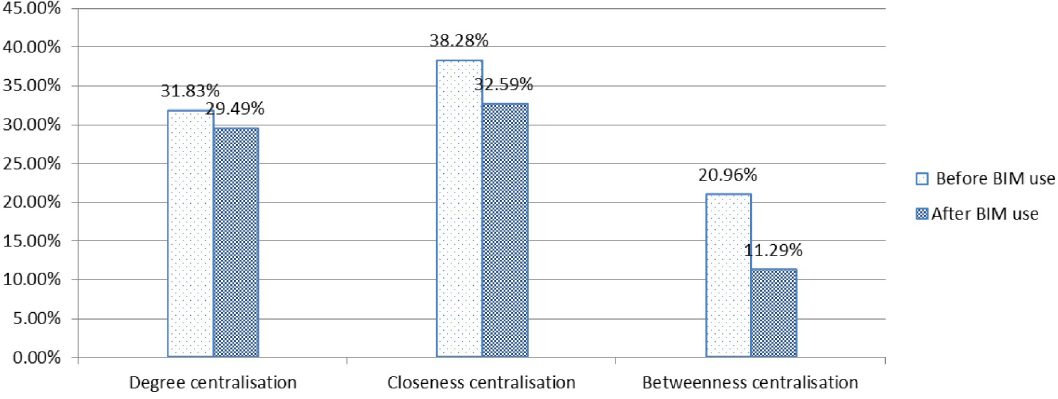
Fig 6. The centralisation of project communication